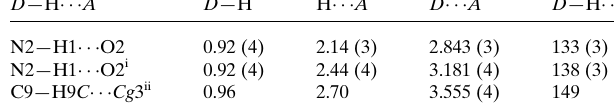
Acta Cryst. (2021). E 77